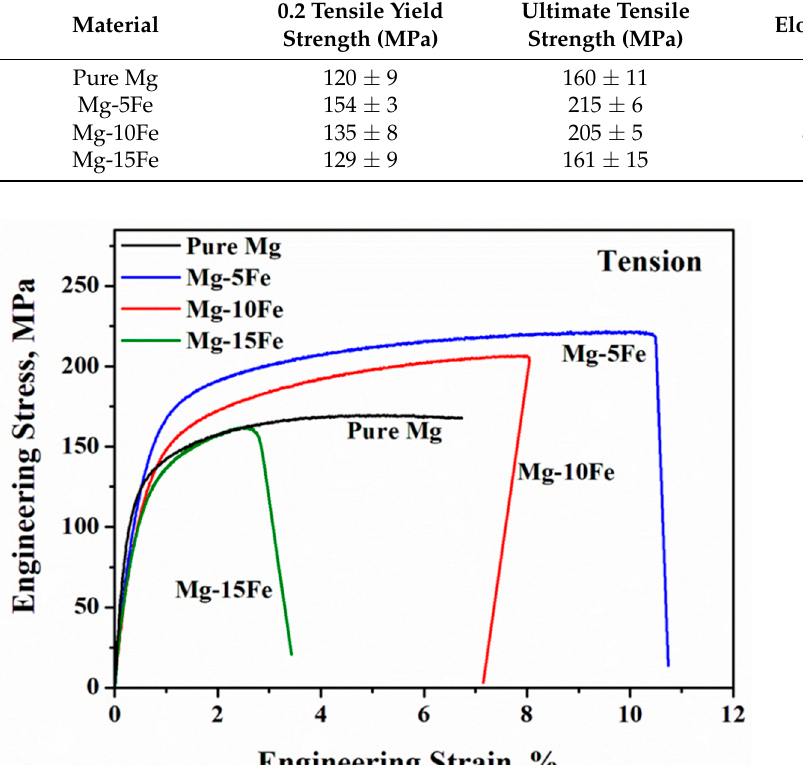
Figure 5. Tensile stress–strain curves of pure Mg and Mg-Fe